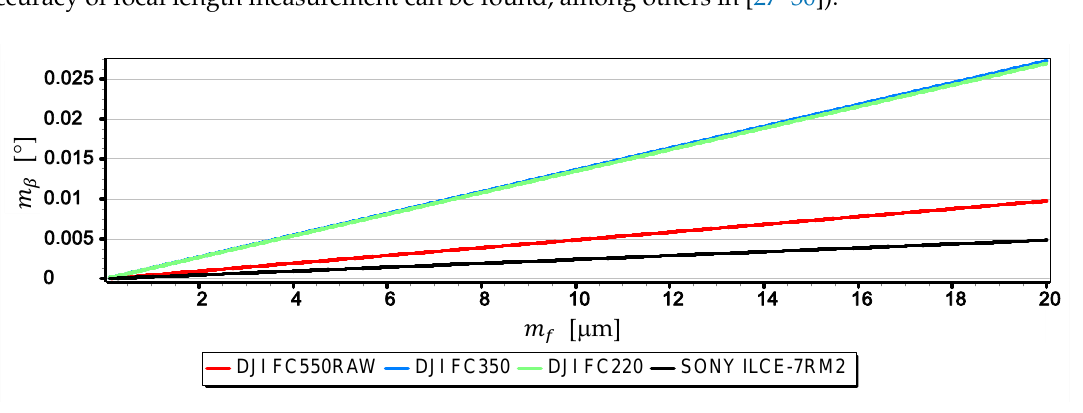
Figure 20. Mean error of measurement m β as a function of m f for β = 5 ◦ (only the first component of the Formula (3) was used in the calculations).